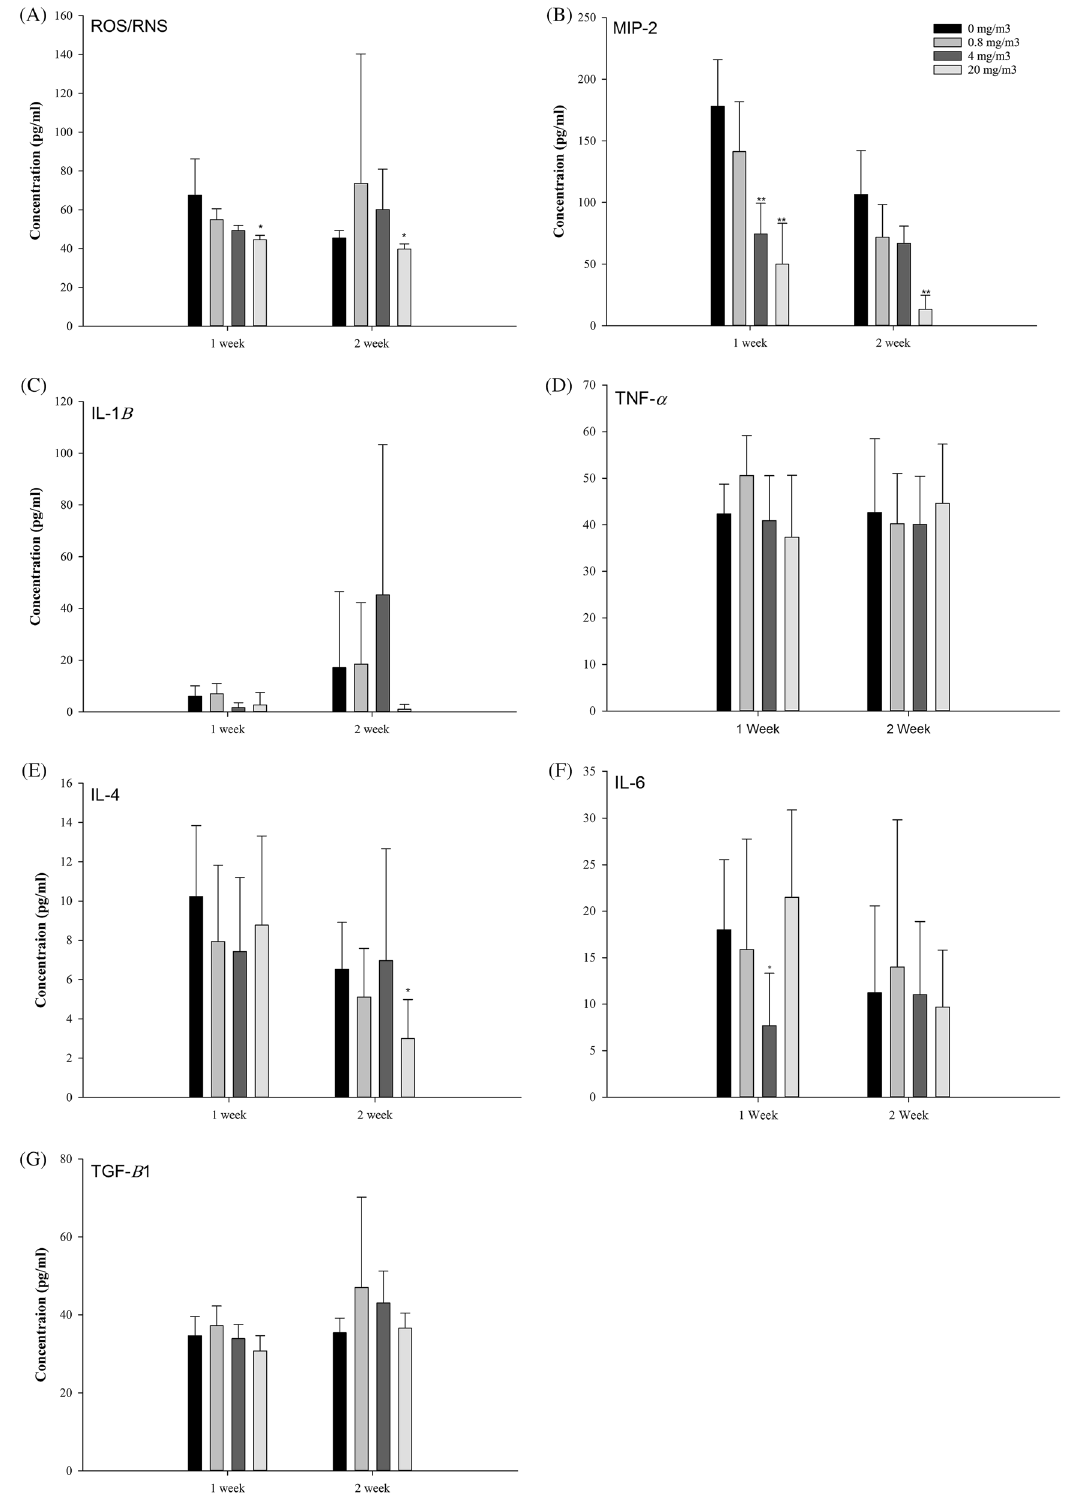
Figure 5. Concentrations of cytokines in bronchoalveolar lavage fluid ( A – G ). The values are expressed as mean ± SD (n = 5 males per group). Significantly different from control by Dunn Rank Sum test: *p < 0.05; **p <